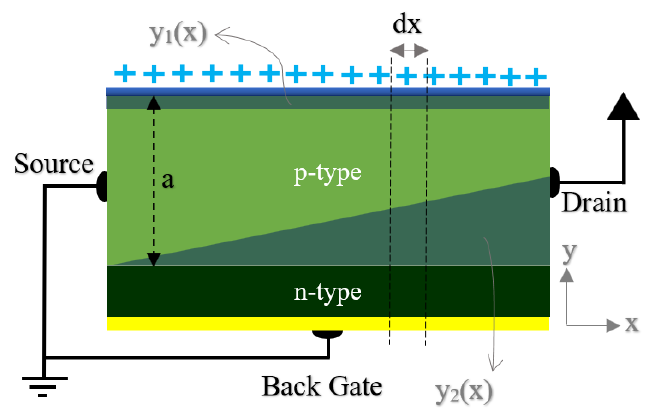
Figure 2. The simplified model of OG ‐ JFET for mathematical modeling of drain–source current. The Vsd (sat) represents the drain–source voltage, which leads to a pinch-off condition at the drain region [65]. According to Figure 2, considering a differential element of the channel in the x direction, we can develop the current–voltage relation by starting with Ohm’s law and extending the equations based on the space charge effects in the channel.